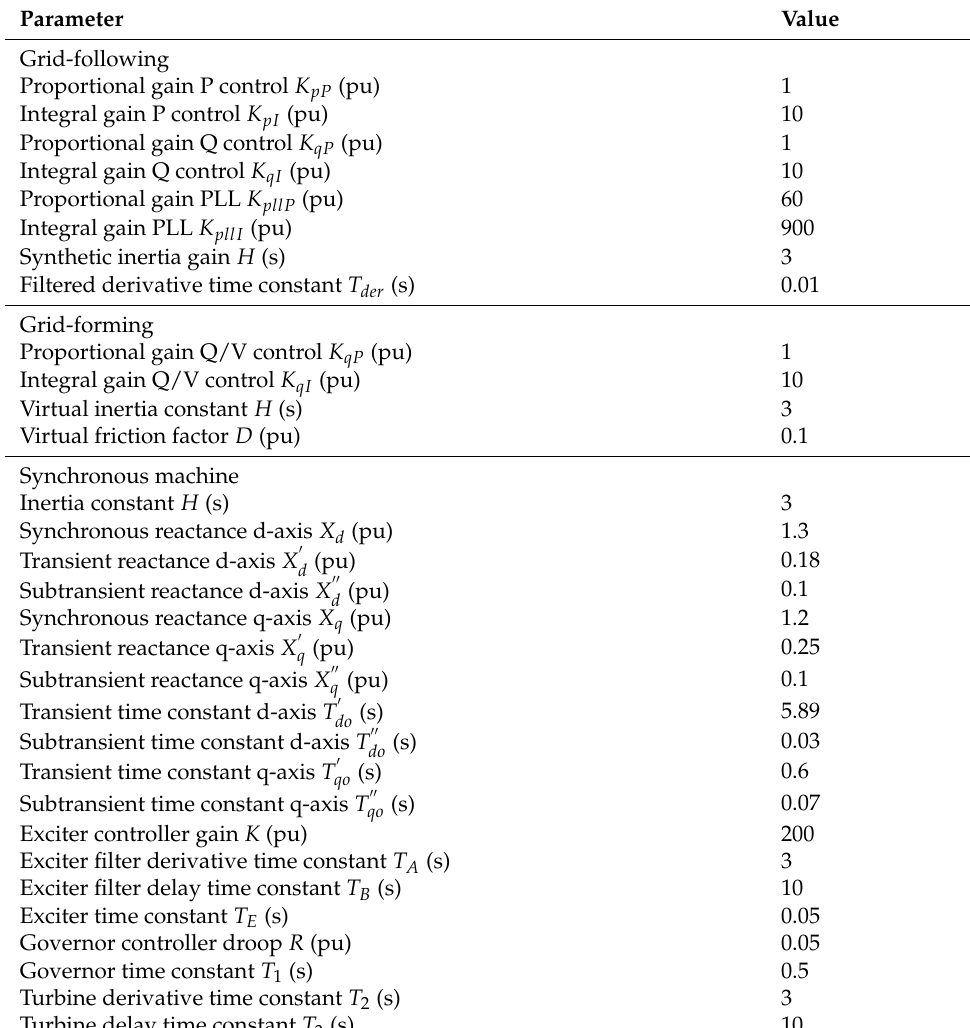
Table 1. Main parameters of the considered testing